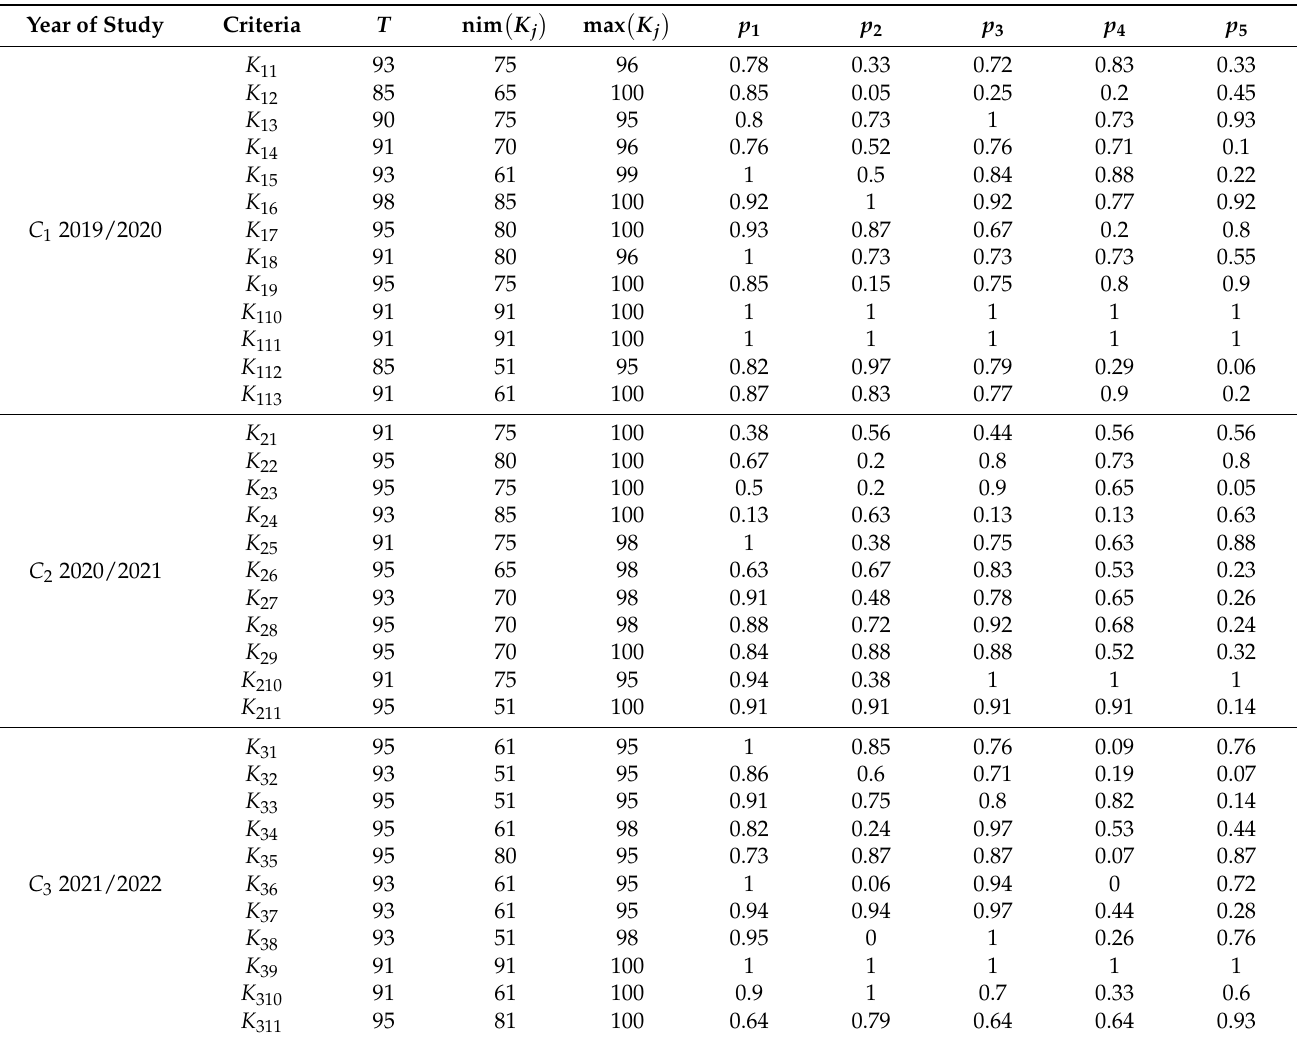
Table 2. Data on the closeness of the study results of the student to the “Importance of